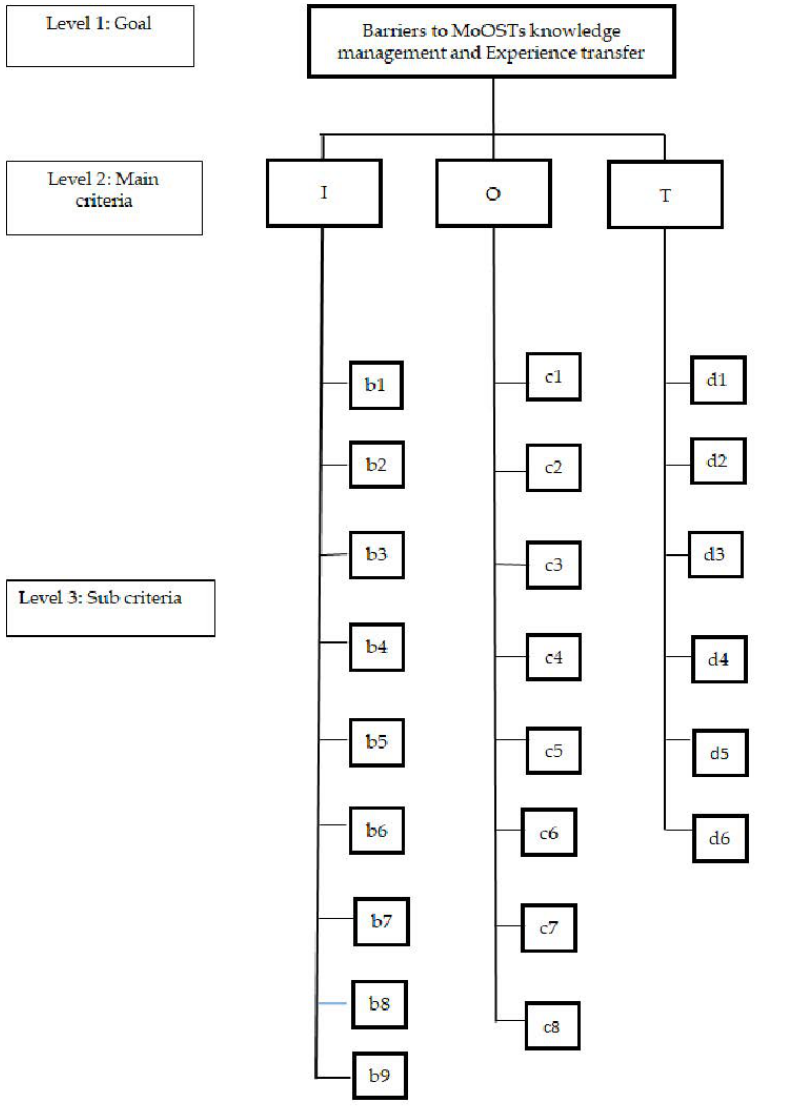
Figure 10. Problem